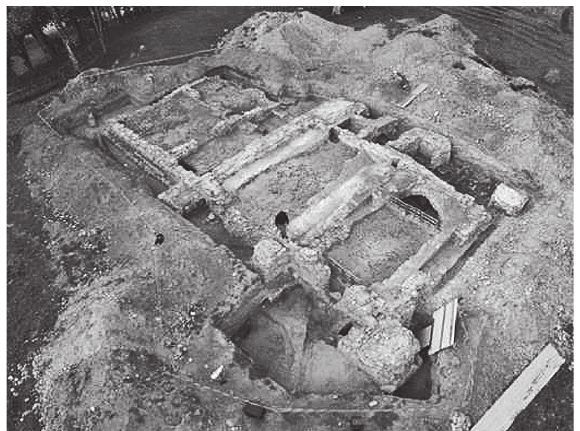
3 pav. atidengtos radvilų rūmų liekanos Dubingiuose, 2008 m. Fig. 3. revealed remains of radvilos castle in Dubingiai,